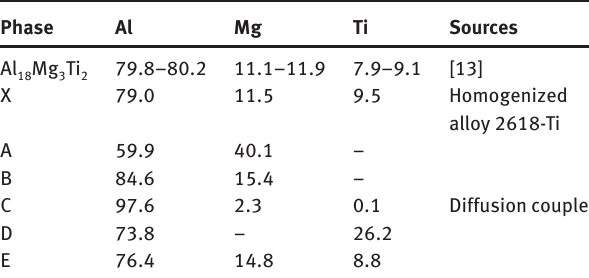
Table 1: Compositions of phases found in this work and Al 18 Mg 3 Ti 2 in Al-Mg-Ti system (at.%)